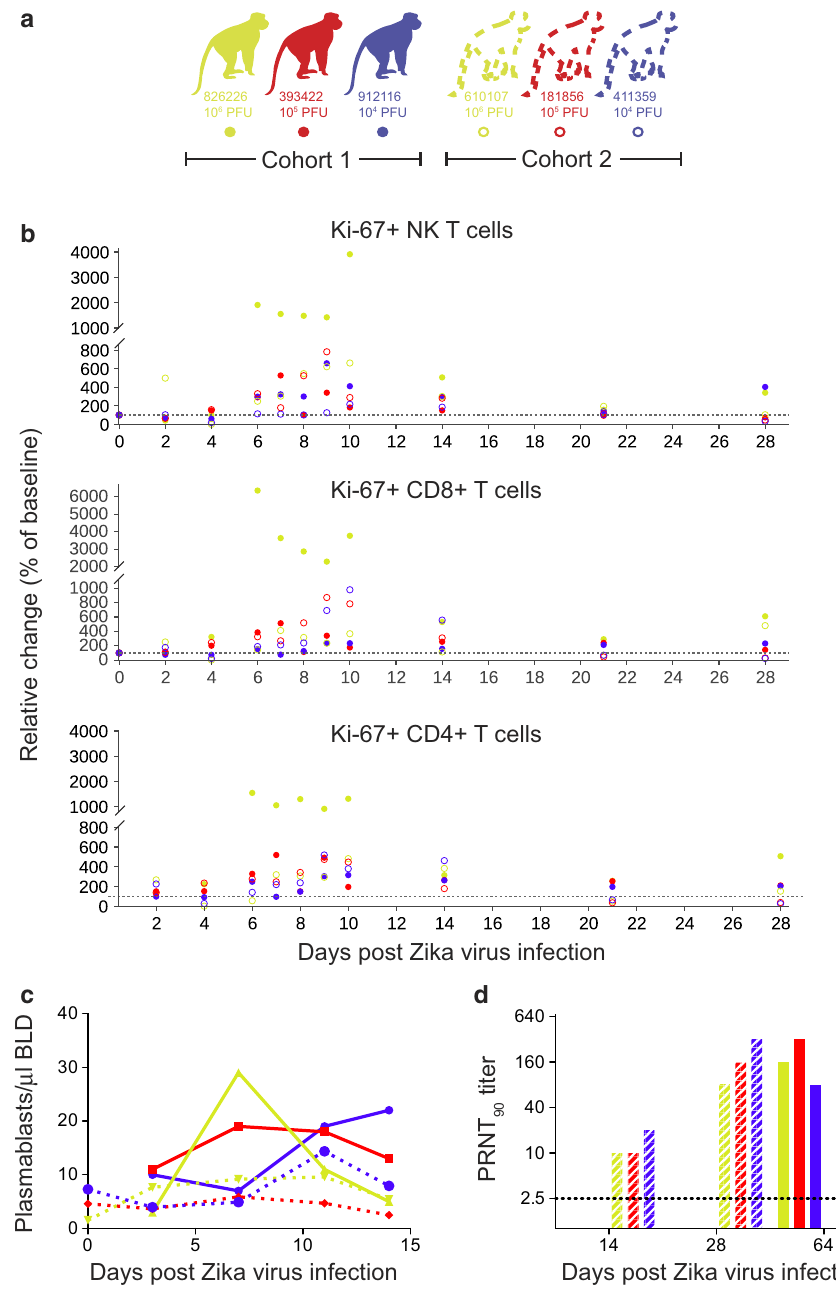
Figure 3 | Immune cell expansion and neutralizing antibody titres following ZIKV infection. ( a ) Solid dots, lines and bars with corresponding colour represent cohort 1 animals and open circles, dotted lines or stripped bars represent cohort 2 animals throughout the figure. ( b ) Expansion of Ki-67 þ (activated) NK cells, CD8 þ Tcells and CD4 þ Tcells were measured daily for 10 days and then on days 14, 21 and 28 post infection. Absolute numbers of activated cells per m l of blood are presented relative to the baseline value set to 100%. ( c ) Total number of plasmablast cells found in PBMCs collected at 0 (cohort 2 only), 3, 7, 11 and 14d.p.i. for each animal. ( d ) PRNT 90 titres for cohorts 1 and 2. The dotted line indicates the first dilution of serum